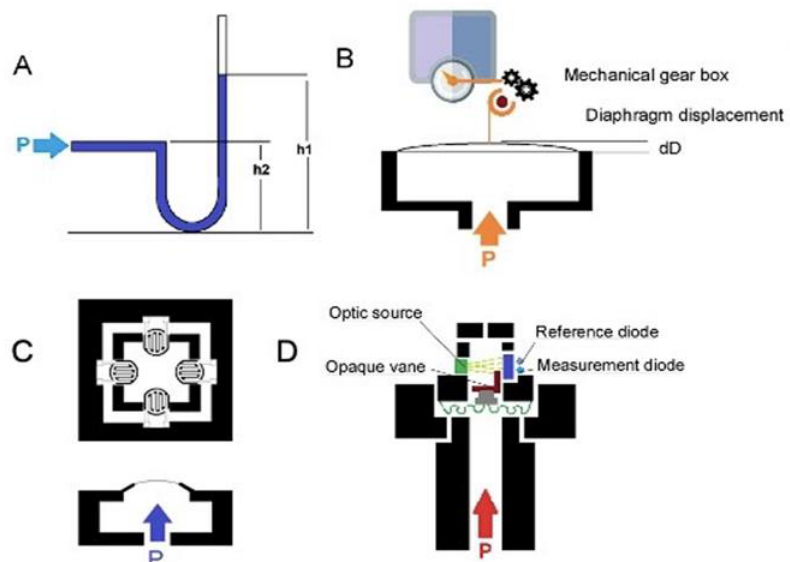
Figure 1. ( A ) Schematic of a water-/air-filled catheter as the pressure transducer; ( B ) schematic of a capacitive diaphragm sensor; ( C ) schematic of a piezoresistive diaphragm sensor; ( D ) schematic of optical fiber pressure sensors.